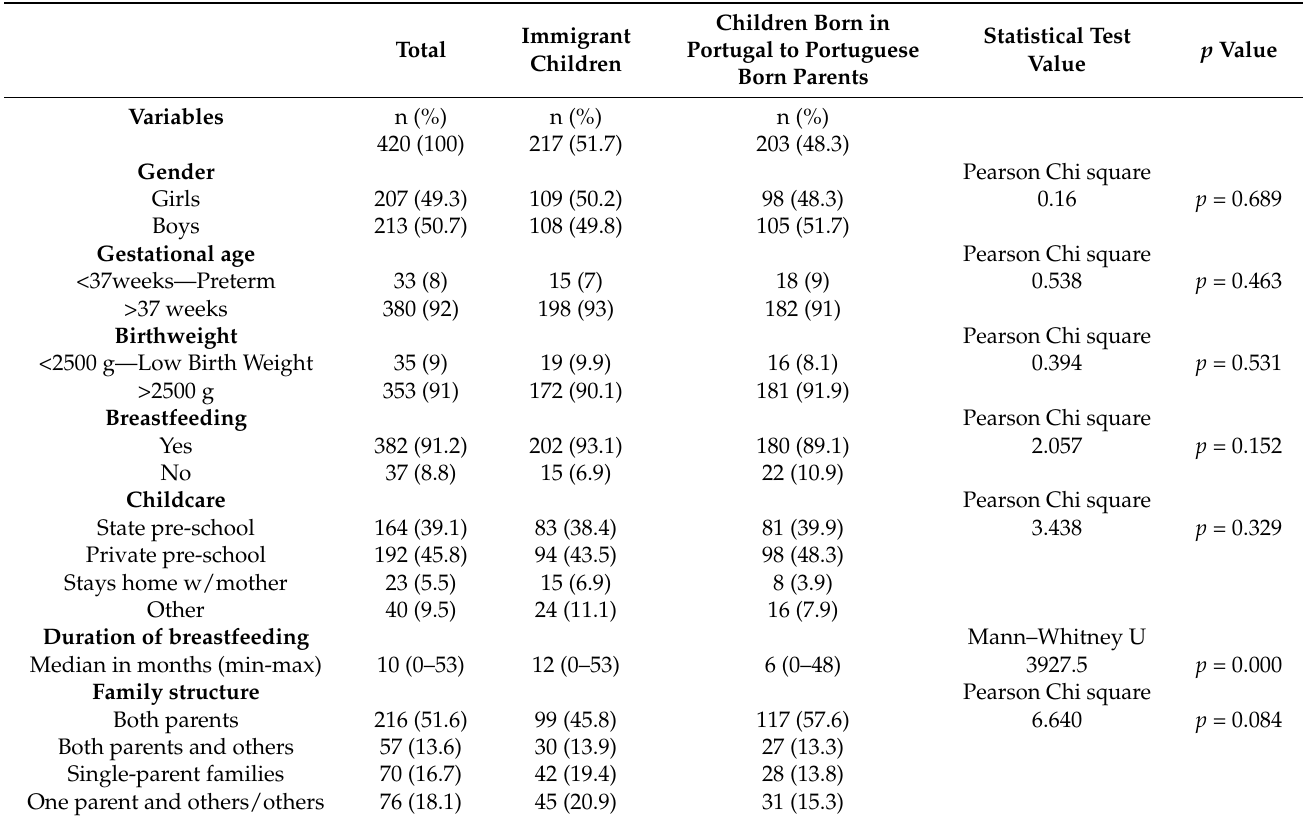
Table 1. Characteristics of the immigrant children versus children born in Portugal to Portuguese-born parents. Children Born Immigrant Total Children